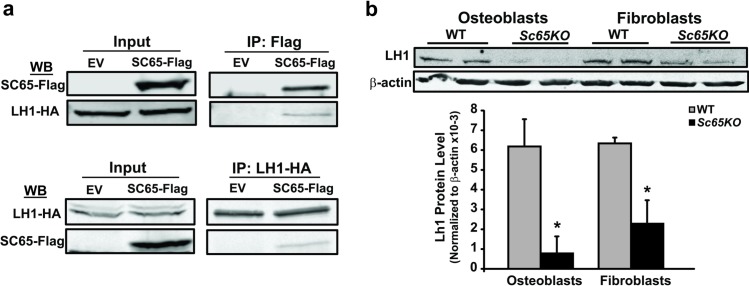
SC65 directly interacts with lysyl-hydroxylase 1 (LH1).a) Murine 714 mouse embryonic fibroblasts stably expressing SC65-Flag or an empty vector (EV) control were transiently transfected with a HA-tagged Lh1 and lysed 48 hours after transfection. Immuno-precipitation (IP) experiments were conducted using a Flag antibody (upper panel) or a HA antibody (lower panel). 10% of total inputs and immuno-precipitates were separated on a 10% SDS-PAGE gel, blotted and probed with antibodies against FLAG and HA. The reciprocal interaction of SC65-Flag with LH1-HA is confirmed in both experiments. b) Western blot of primary calvarial osteoblast and skin fibroblast lysates from WT and Sc65KO 3 day-old mice (N = 2) showing significantly decreased levels of LH1 protein in Sc65KO samples. Densitometric quantification of LH1 protein normalized to β-actin from the western blot shown above (*p<0.05; error bars represent SD). All experiments were performed at least 3 times.